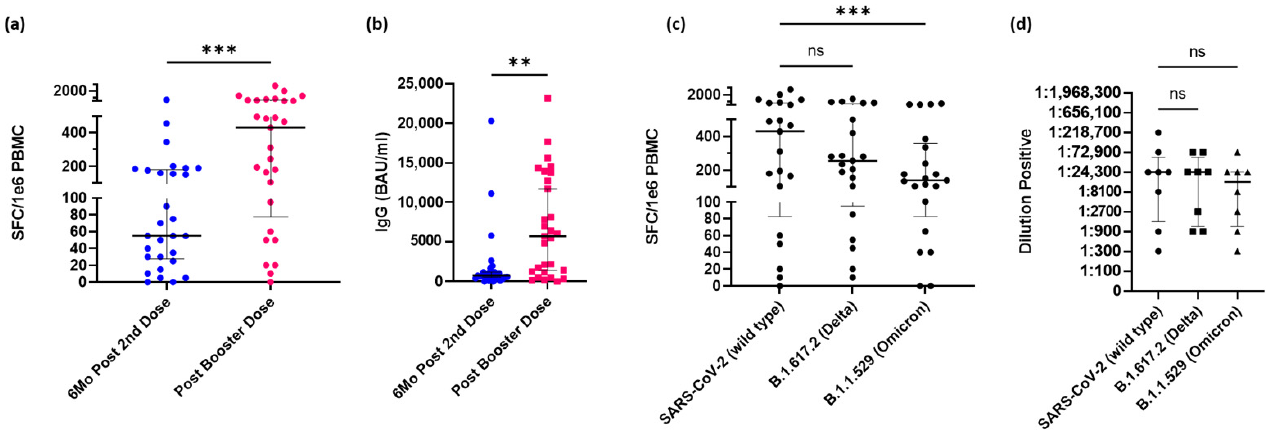
Figure 2. mRNA vaccine Booster dose increases immune response to SARS-CoV-2 spike protein and recent variants of concern in oncology workers. ( a ) Spike-specific CD4 + T-cell response in participants within 6 months of their last dose of a vaccine and after they have received a booster dose ( n = 29). ( b ) Spike-specific IgG antibody response from the same participants. ( c ) Spike-specific CD4 + T-cell response to the wild type, Delta, and Omicron variants following a third dose ( n = 21). ( d ) Spike-specific antibody response to the wild type, Delta, and Omicron variants following a third dose ( n = 8) Middle black bar represents median with outer bars representing interquartile range. The Wilcoxon signed-rank test ( a , b ) or Friedman test ( c ) was used for group comparisons. Abbreviation: SFC, spot forming cells; IgG, immunoglobulin G; BAU, binding antibody units; ns, no significance. ** p < 0.01, *** p < 0.001.